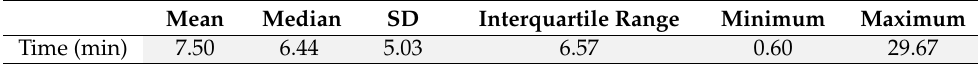
Table 5. Results—navigation device log